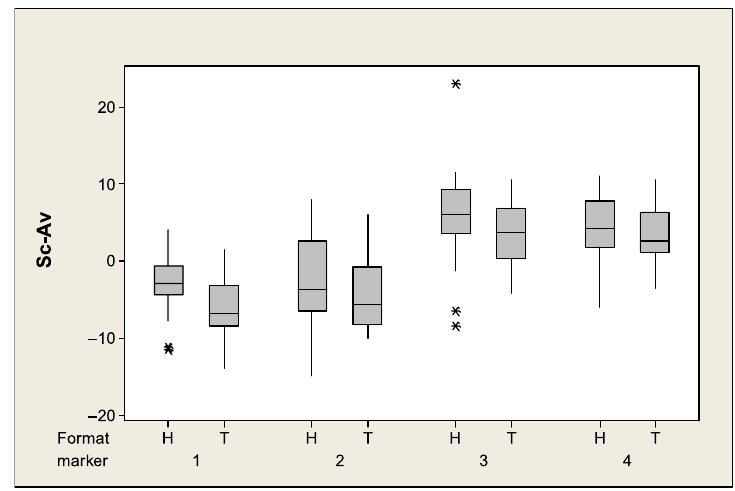
Figure 6. Boxplot of variations in score from the mean by marker then format.